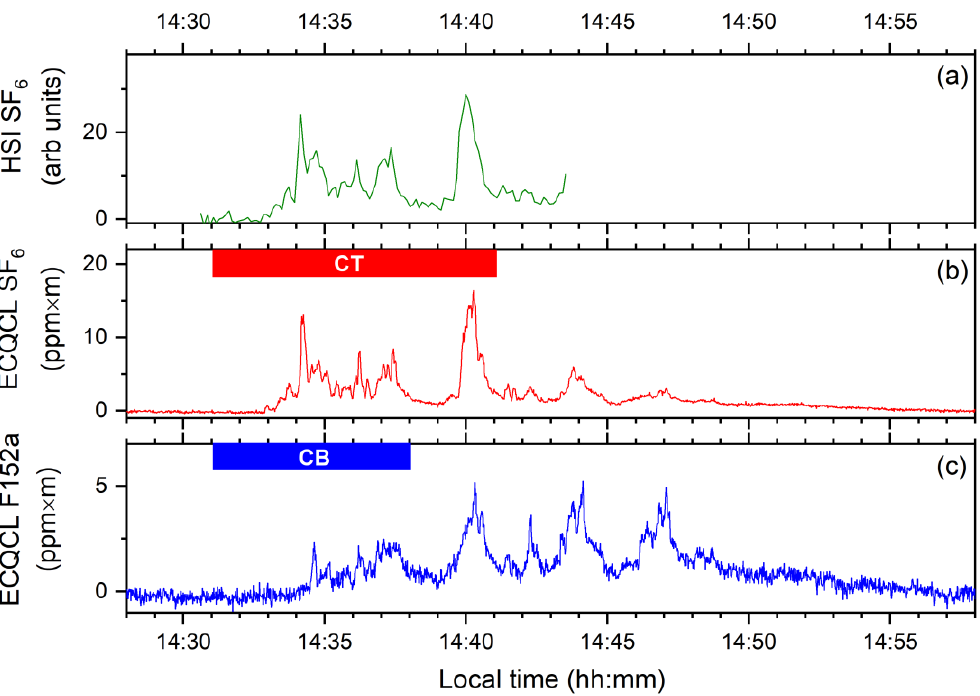
Figure 8. Time-resolved detection of plumes for SF 6 released from the CT location and F152a released from the CB location. ( a ) SF 6 absorbance versus time detected by LWIR-HSI in the spatial region near the retroreflector. ( b ) SF 6 column density measured with the swept-ECQCL system. ( c ) F152a column density versus time measured with the swept-ECQCL system. The solid red and blue bars indicate the times over which SF 6 and F152a were released, respectively.